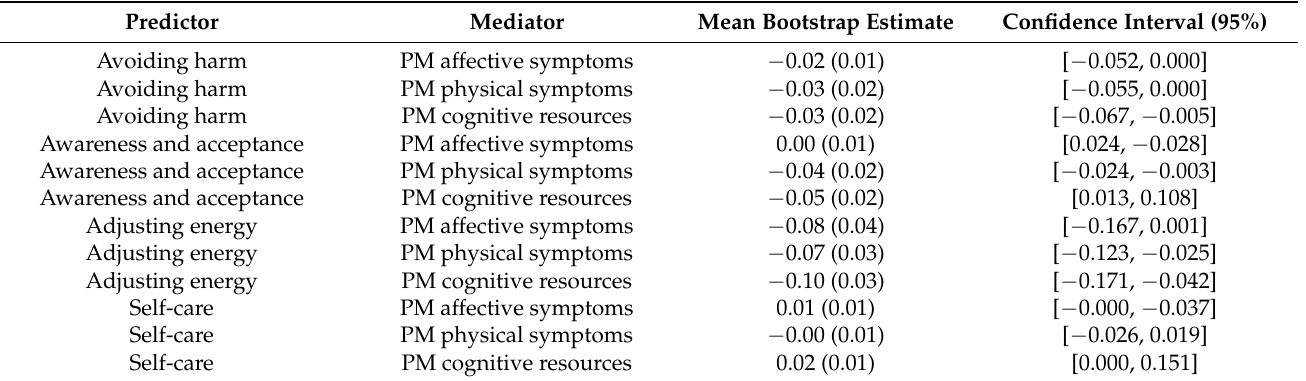
Table 3. Indirect effects in Model 1 with perceived physical ability (PPA) as the dependent variable.